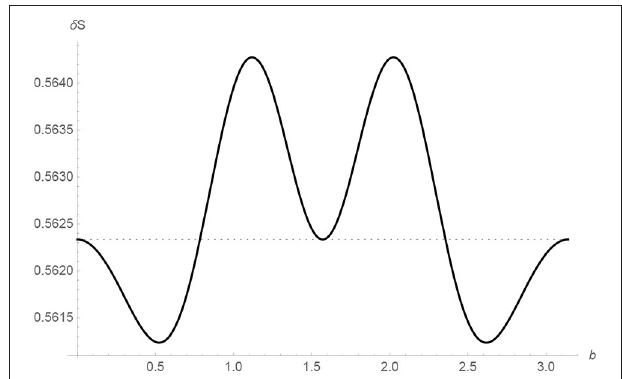
FIGURE 7 | The entropy jump δ S as a function of b in Planck units for γ µ 1 1. The small b ℓ p behavior in (93) is apparent. The entropy is = = − = periodic for b ℓ p [0, π ] as expected from ∈